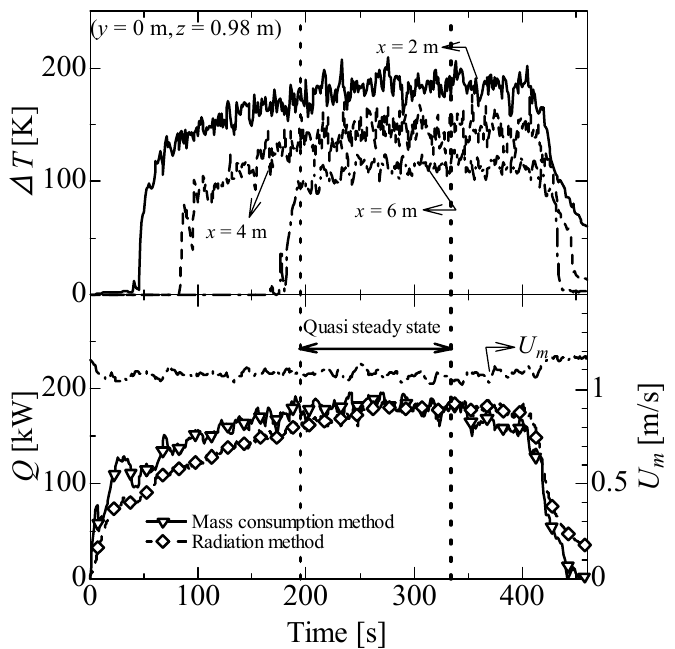
Fig. 3 Time curves of the heat release rate measured by an electric balance and a radiometer, ventilation velocity measured by anemometers installed in four positions, and temperature rise at thermocouples in three different positions: x = 2, 4, 6 m, y = 0 m, z = 0.98 m, in the case of the burning area A f = 0.15 m